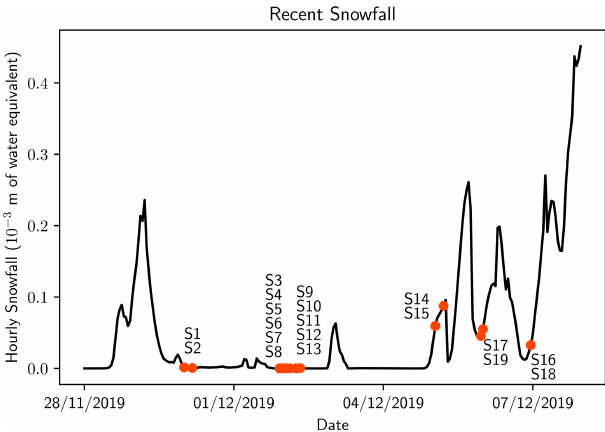
Figure 2. Snowfall over the measurement period from the ERA5 reanalysis. These values are averaged over the sample site area (77.75–78 ◦ S, 166.5–167.25 ◦ E). Orange circles indicate the time when samples were taken with nearby text indicating the sample